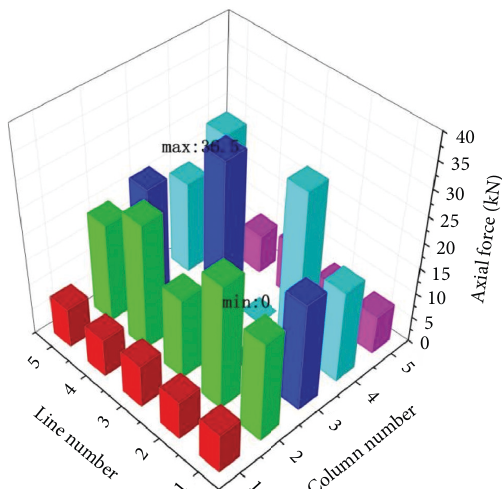
Figure 13: Axial force distribution of 25 vertical poles in sample C2-5.